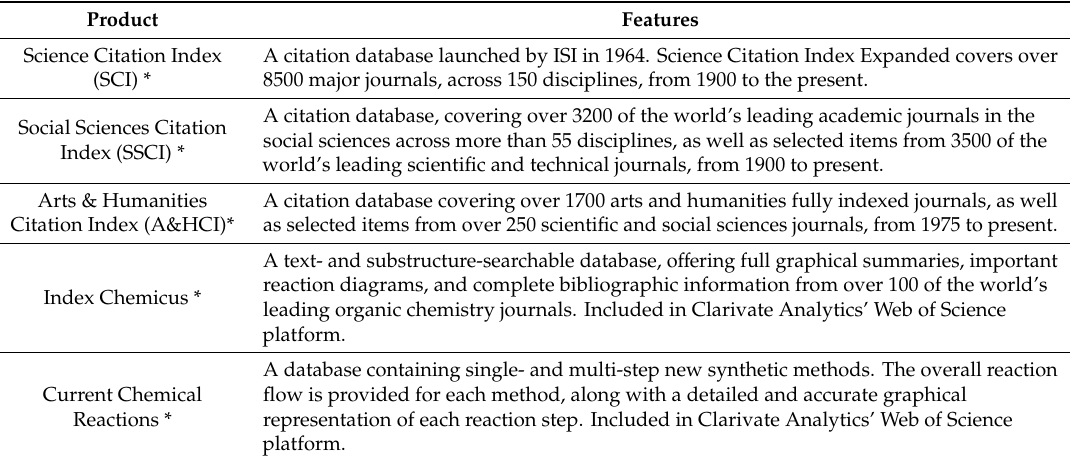
Table 1. Information products associated with the legacy of Eugene Garfield.